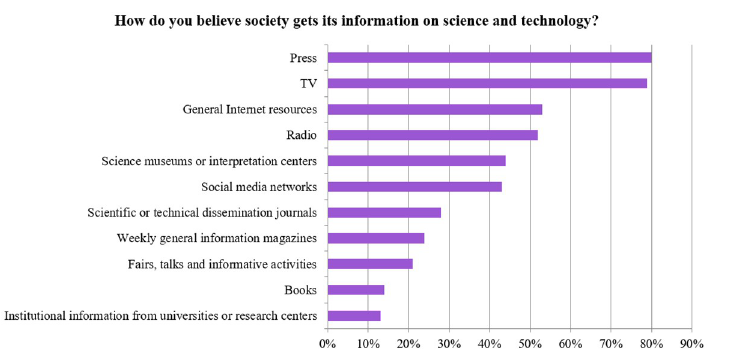
Fig 2. Scientists’ views of how the public is informed about science and technology.